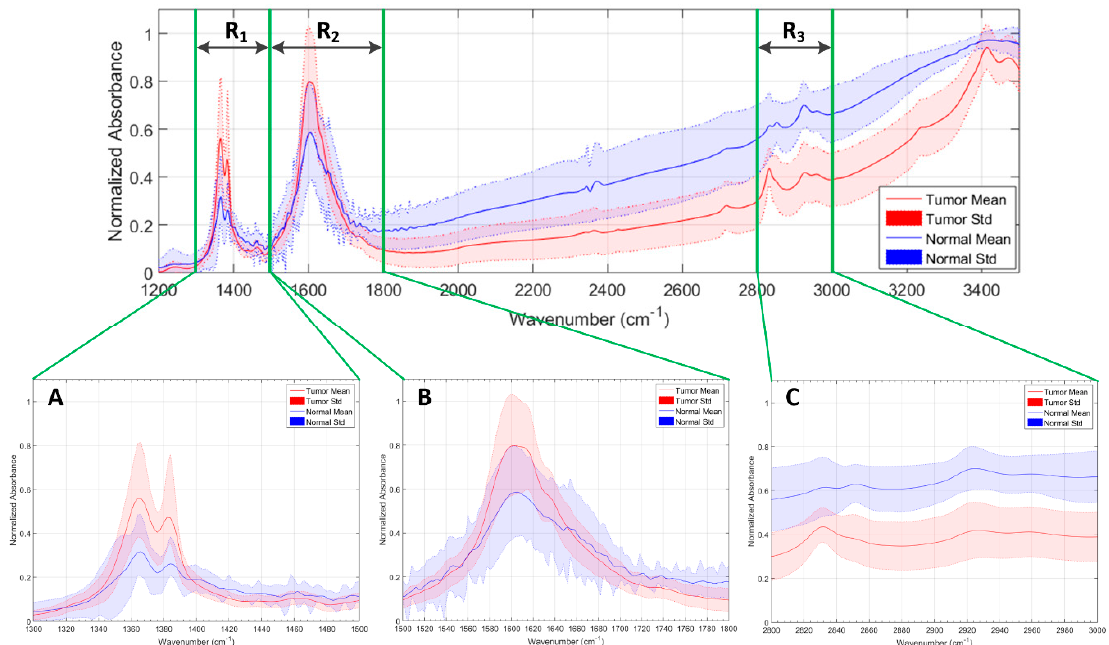
Figure 7. Average specificity ( a ) and sensitivity ( b ) results obtained (using the 10 × 5 cross-validation) with the optimal hyperparameters for each kernel type in the DL3 (normal mixed vs. grey matter vs. white matter vs. grade IV vs. grade III vs. grade II).